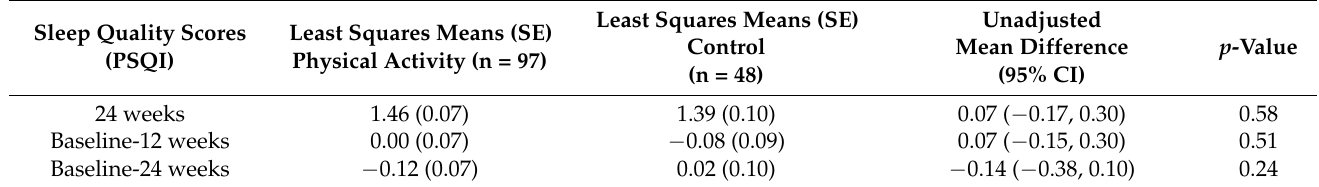
Table A6. Disturbances Component.